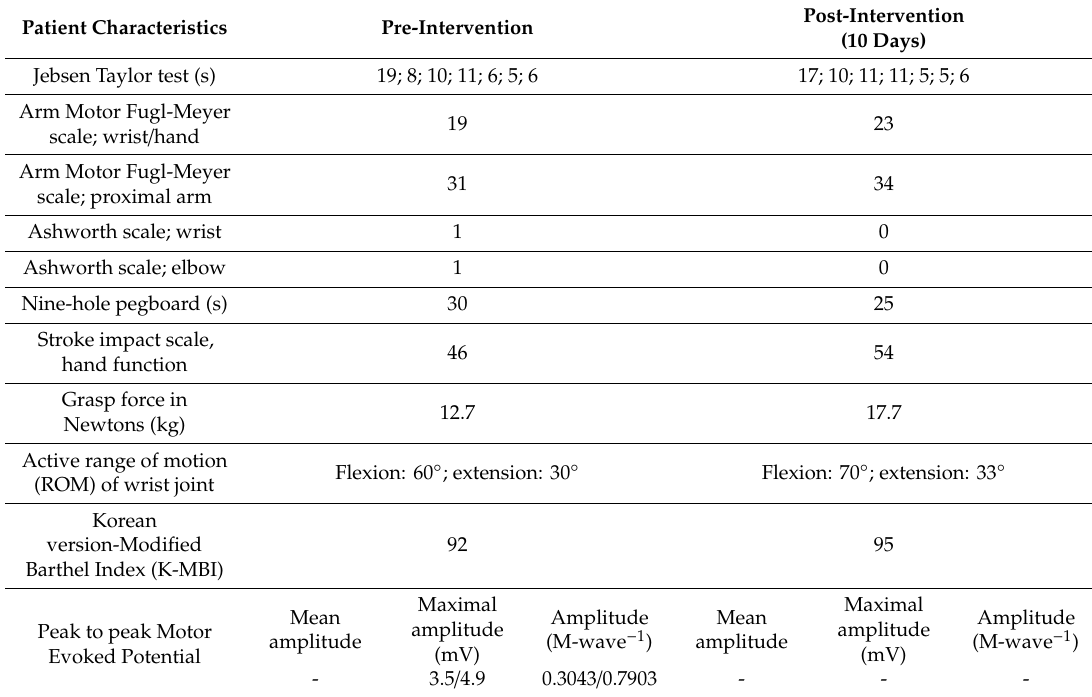
Table 2. Upper extremity motor function measures before and after the